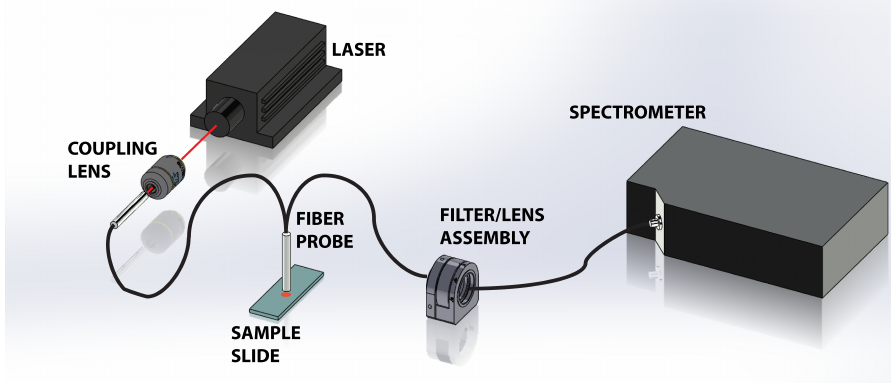
Figure 1. Schematic of the experimental setup showing the 785 nm laser directed into the Raman probe via the 10 × objective lens. The probe illuminates the tissue sample and collects the scattered